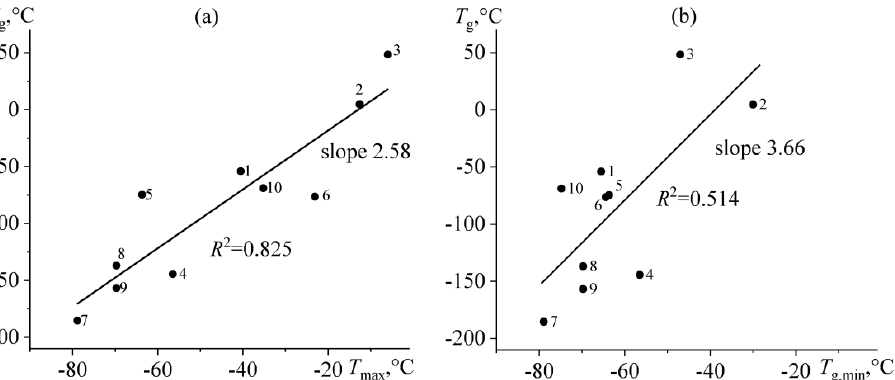
Figure 14. Correlation dependences of the viscometric glass transition temperature on the highest ( a ) or lowest ( b ) glass transition temperatures determined by calorimetry. Bitumen numbers are given near experimental points.